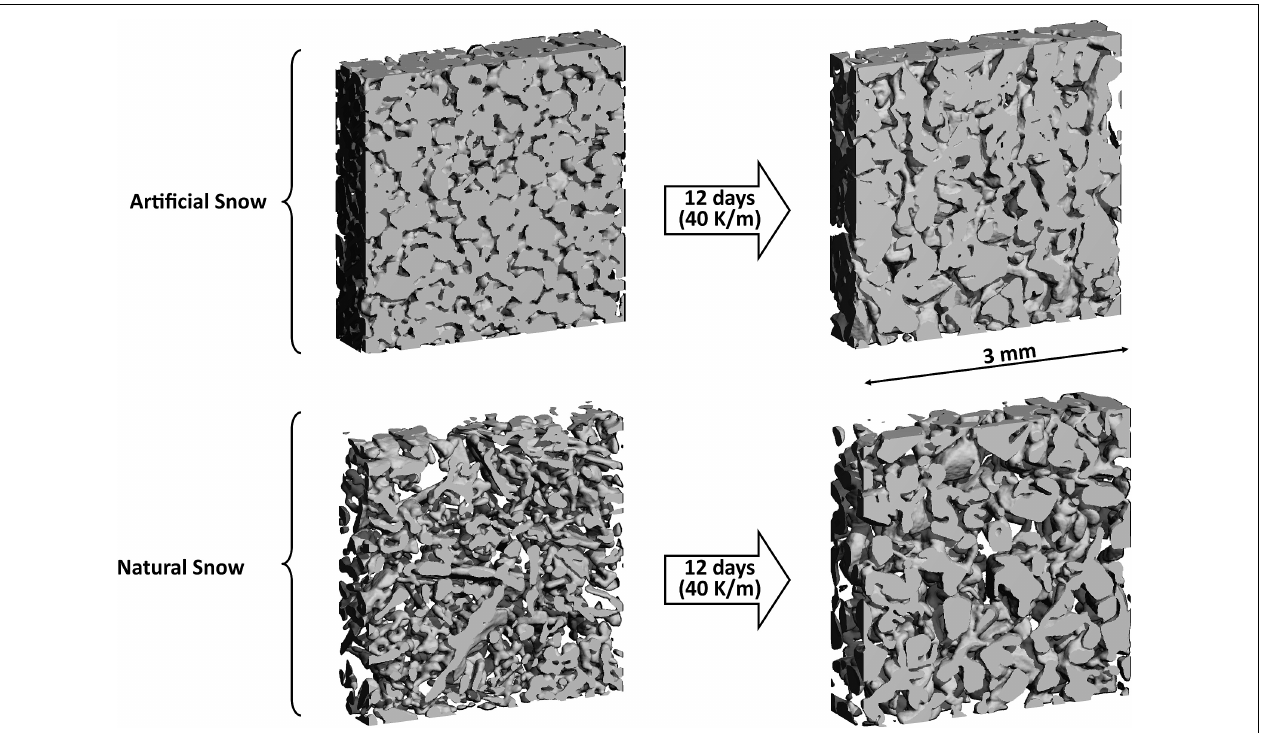
FIGURE 3 | Qualitative evolution (3D microstructure) of artificial and natural snow under an artificial temperature gradient of 40 K/m imaged by microCT after 0 days (left) and 12 days (right). The dimensions of the observed sub-volume of the measured field of view are 3 mm × 3 mm × 0.5 mm.